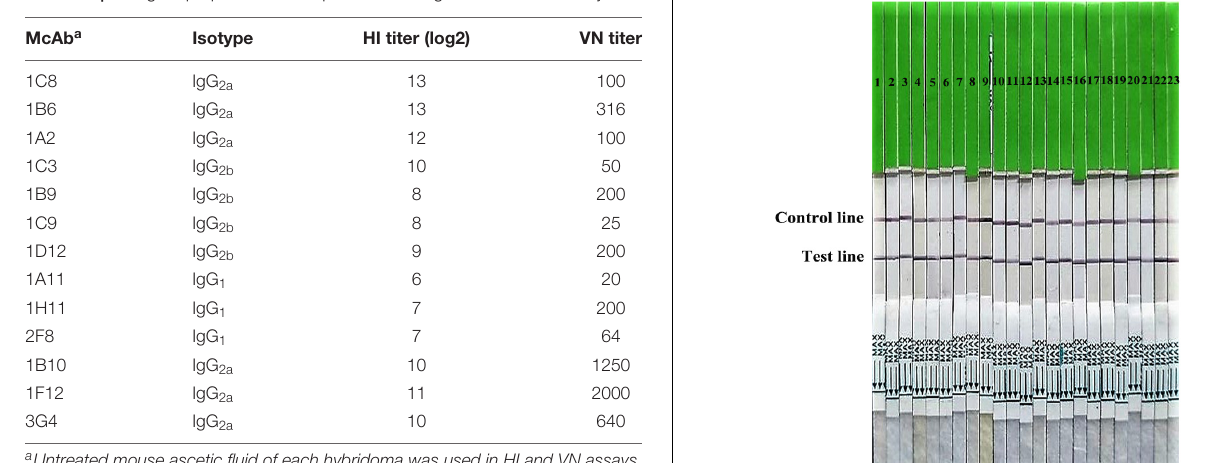
TABLE 1 | Biological properties of H7-specific McAbs generated in this study.